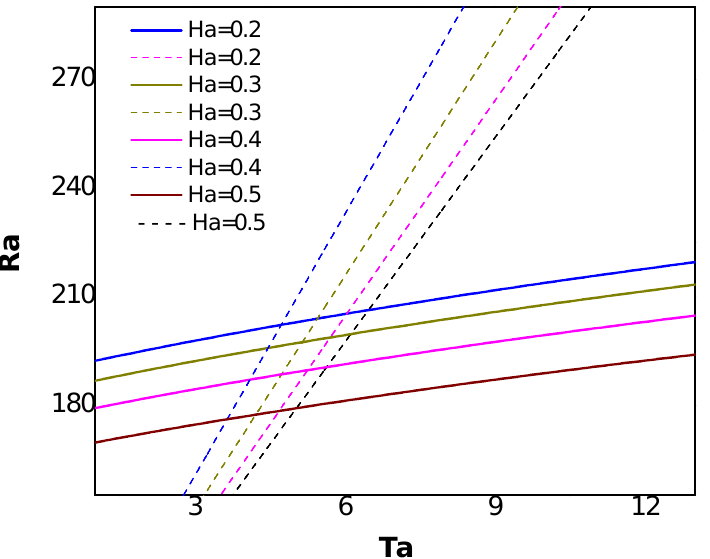
Figure 9. Plots of critical Ra as the function of Ta for Dm = 5, Va = 5, Ha = 0.2, 0.3, 0.4, 0.5.